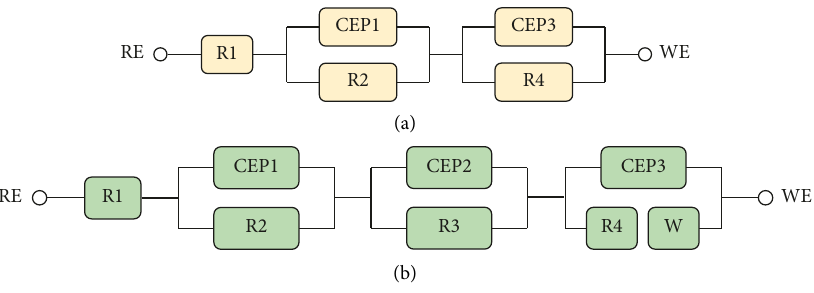
Figure 6: Equivalent circuit model under passivation and